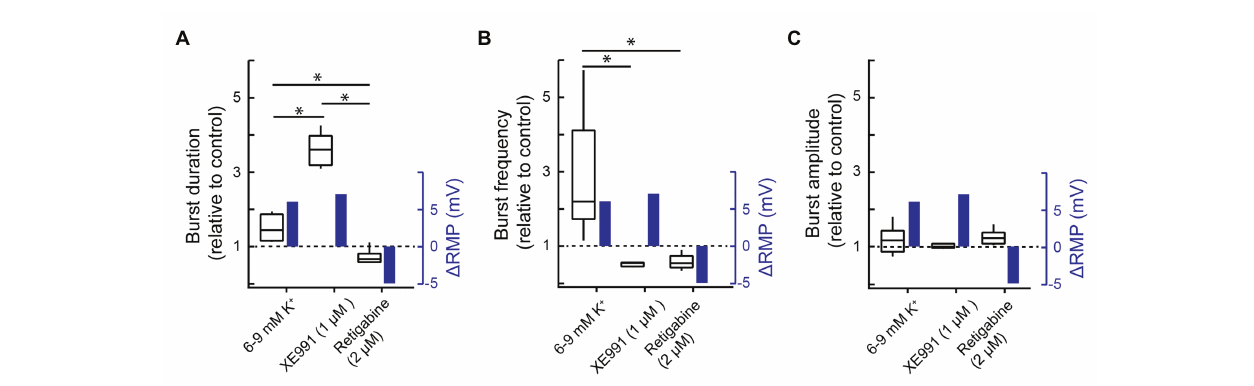
FIGURE 7 | Effects of altering membrane potential vs. KCNQ modulation on inspiratory burst behavior. (A) Group data showing the relative change in XII inspiratory burst duration (left-hand y -axis) and the change in resting membrane potential (blue, right-hand y -axis) evoked by increasing [K + ] e from 6 to 9 mM ( n = 4) or bath applying XE991 (1 μ M, n = 5) or retigabine (2 μ M, n = 8). (B) Group data showing the effects of increasing [K + ] e (6–9 mM, n = 11) or bath applying XE991 (1 μ M, n = 5) or retigabine (2 μ M, n = 8) on inspiratory burst frequency (relative to control) and resting membrane potential. (C) Group data showing effects of increasing [K + ] e (6–9 mM, n = 13) or bath applying XE991 (1 μ M, n = 5) or retigabine (2 μ M, n = 8) on inspiratory burst amplitude and resting membrane potential. The change in resting membrane potential evoked by increasing extracellular K + concentration from 6 to 9 mM was measured in pre-Bötzinger complex (preBötC) inspiratory neurons ( n = 5); the change in resting membrane potential associated with XE991 was estimated using Ohm’s law and the XE991-evoked current measured under voltage clamp and the input resistance of the recorded neurons ( n = 5, Figure 1 ); the retigabine-evoked change in resting membrane potential was measured at − 40 mV ( Figure 2 , n = 7). * p < 0.05, one-way ANOVA with Tukey’s multiple comparisons post hoc